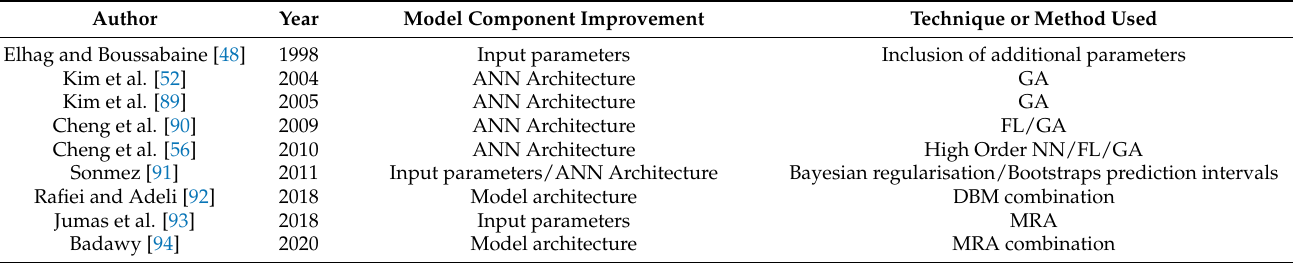
Table 5. Improvements in ANN models from studies.